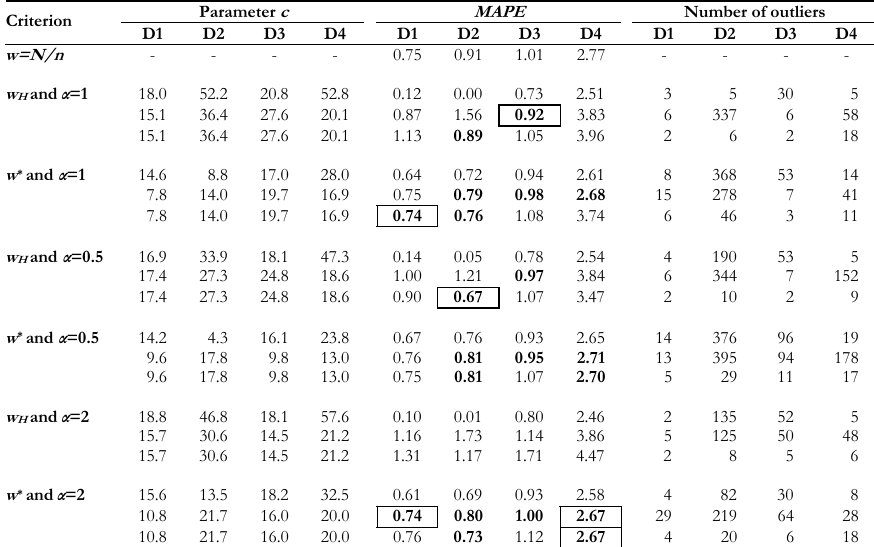
Comparison among estimation strategies – Average of quarterly 2007 estimates for the wholesale trade turnover Parameter c MAPE Number of outliers Criterion